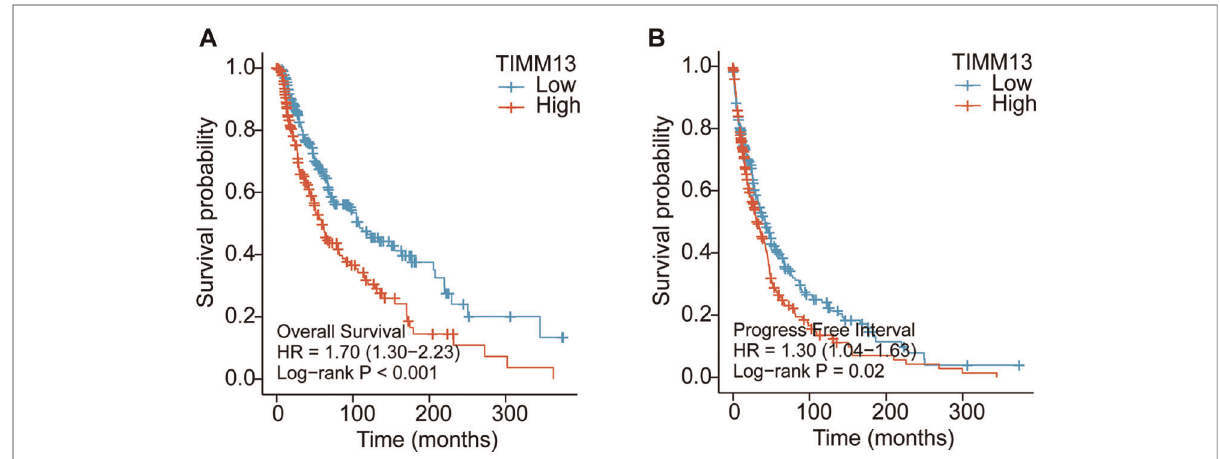
FIGURE 3 Kaplan – Meier survival curves comparing the high and low expression of TIMM13 in SKCM by using Xiantao tool. Survival curves of OS ( A ), FPI ( B ) in the SKCM patients. OS, overall survival; PFI, progression free